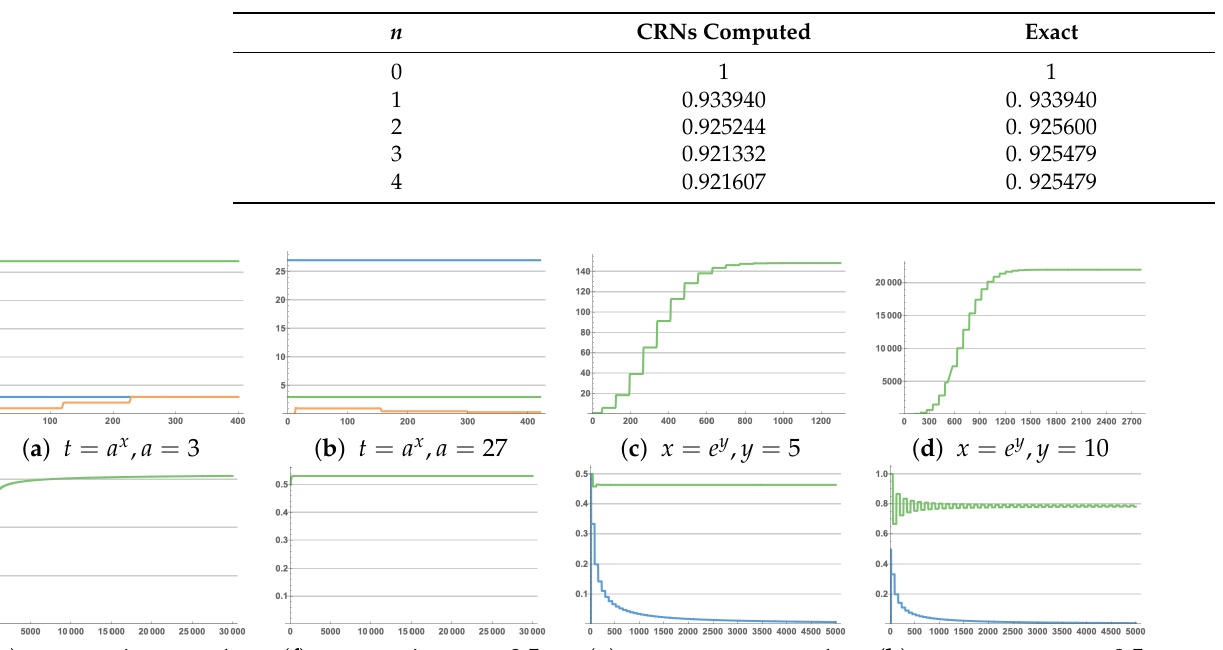
Table 1. Comparison of the calculated value in CRNs and the exact value.